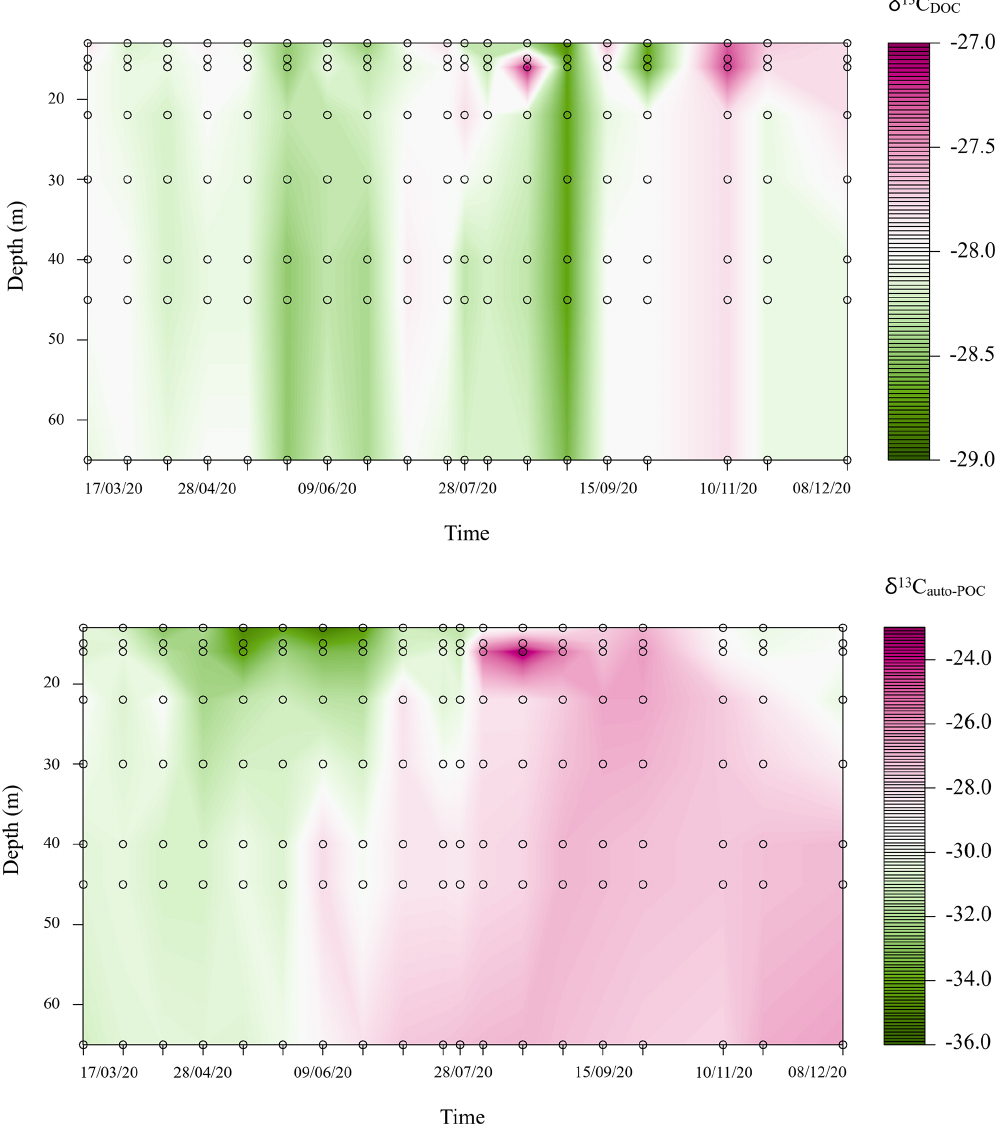
Figure 3. Carbon stable isotope variations (‰) of dissolved organic carbon (DOC) and autochthonous particulate organic carbon (auto-POC) during the observation period in the metalimnion and hypolimnion of Rappbode Reservoir. Table 1. Equations of the regression lines for autochthonous particulate organic carbon (auto-POC), dissolved organic carbon (DOC), sed- imentary material (SED), and allochthonous particulate organic carbon (allo-POC) in the metalimnion, MOM, and hypolimnion of the Rappbode Reservoir. The coefficient of determination ( R 2 ) is reported below each equation. All p values <